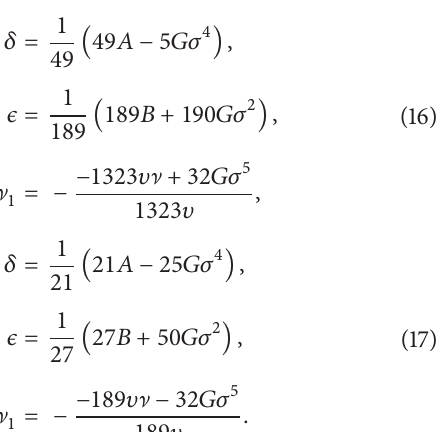
Figure 1: Amplitude-time response curves of (1) and (15). Here, the solid line represents the numerical integration solution of (1), while the dashed line represents the prediction obtained by using thederivedequivalentequationofmotionbyapplyingourenhanced cubication procedure. The parameter values are 𝛼 = 5 , 𝛽 = 2 , and 𝛾 = 0.5 , and ] = 0.1 with 𝑦(0) = 1 and ̇𝑦(0) = 0